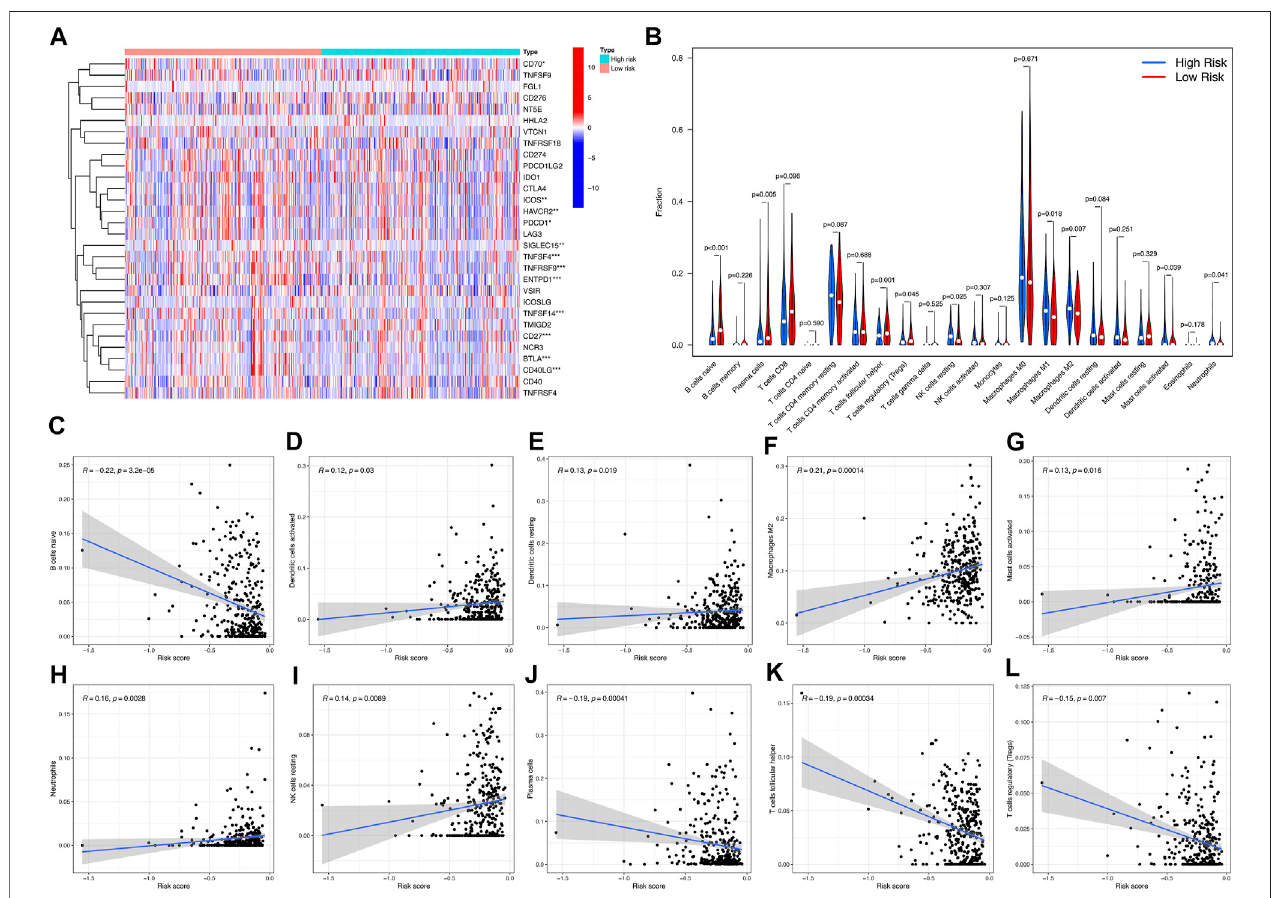
FIGURE 6 | Differences in immune microenvironment between high-risk and low-risk subgroups. (A) Violet plot of the expression of different checkpoint genes between high-risk subgroup and low-risk subgroup. (B) Heatmap of in fi ltration of different immune cells between high-risk subgroup and low-risk subgroup. (C – L) The correlation between immune cell in fi ltration and risk